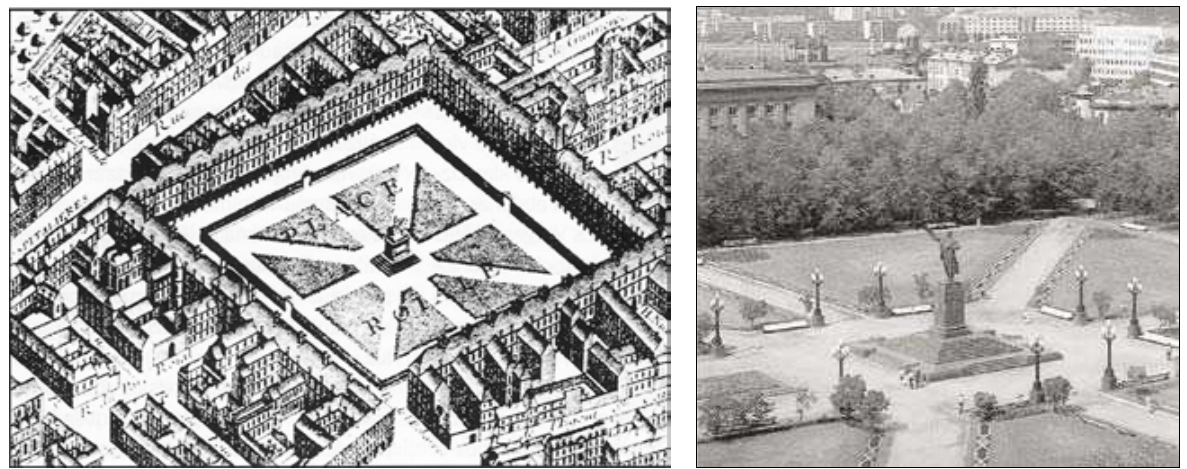
Fig. 8. Extract from T. Grunskis’ article ’’The dictate architecture. Lukiškės Square“